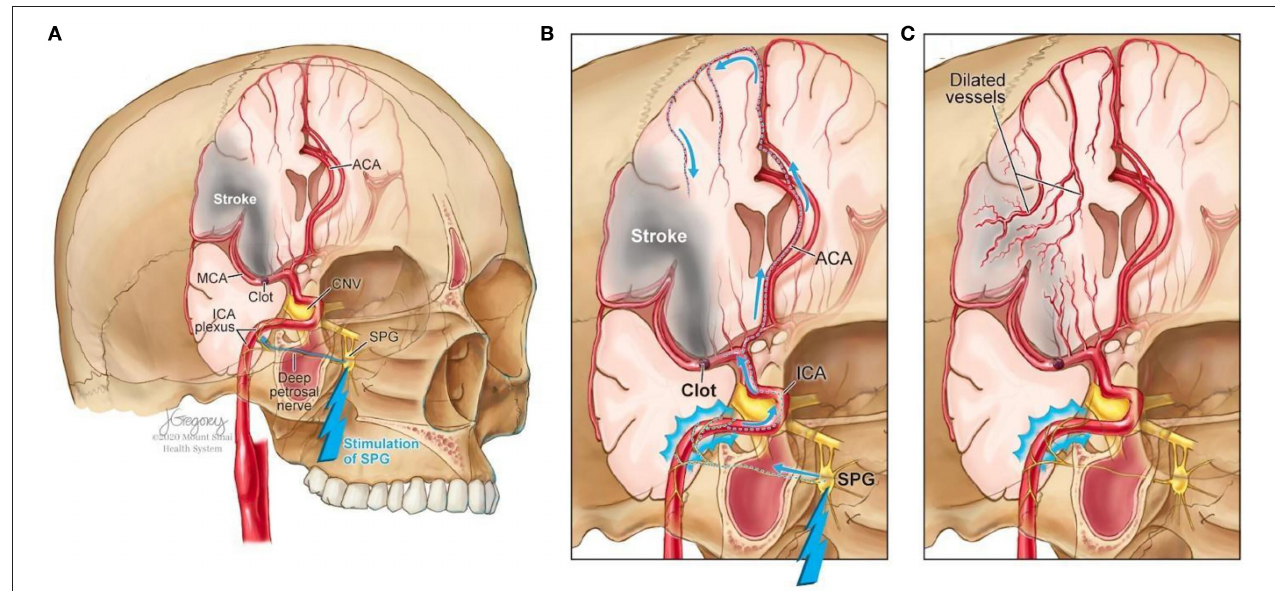
FIGURE 1 | Increased collateral blood circulation by sphenopalatine ganglion (SPG) stimulation. (A) Anatomical overview of stroke affected brain region before SPG stimulation. (B) The SPG contains parasympathetic fibers that synapse in the ganglion and innervate the internal carotid artery (ICA) through the deep petrosal nerve. (C) SPG stimulation induces vasodilation of blood vessels in the anterior circulation, increasing blood flow to the affected area limiting the evolution of the penumbra and reducing infarct